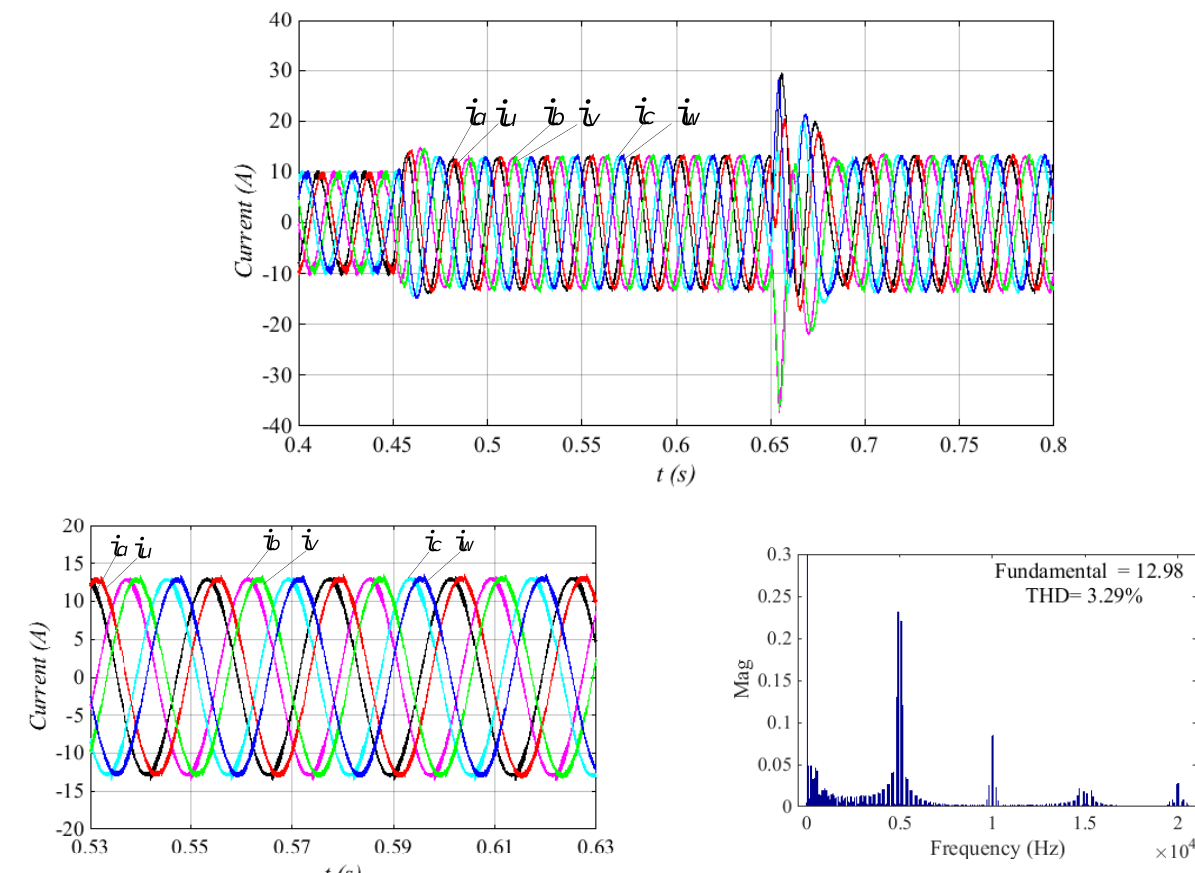
Figure 15. Simulation results of the six-phase current and the FFT analysis of the steady state cur- rent i a for DZIPWM.